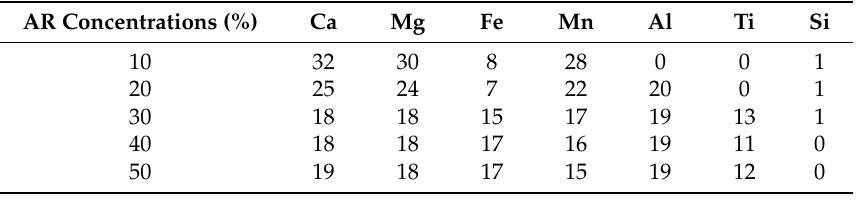
Figure 3. Comparison of the leaching ratio (LCH. R) of elements corresponding to the AR concentration at a leaching time of 20 min. Table 3. Selectivity of elements from leaching experiments.